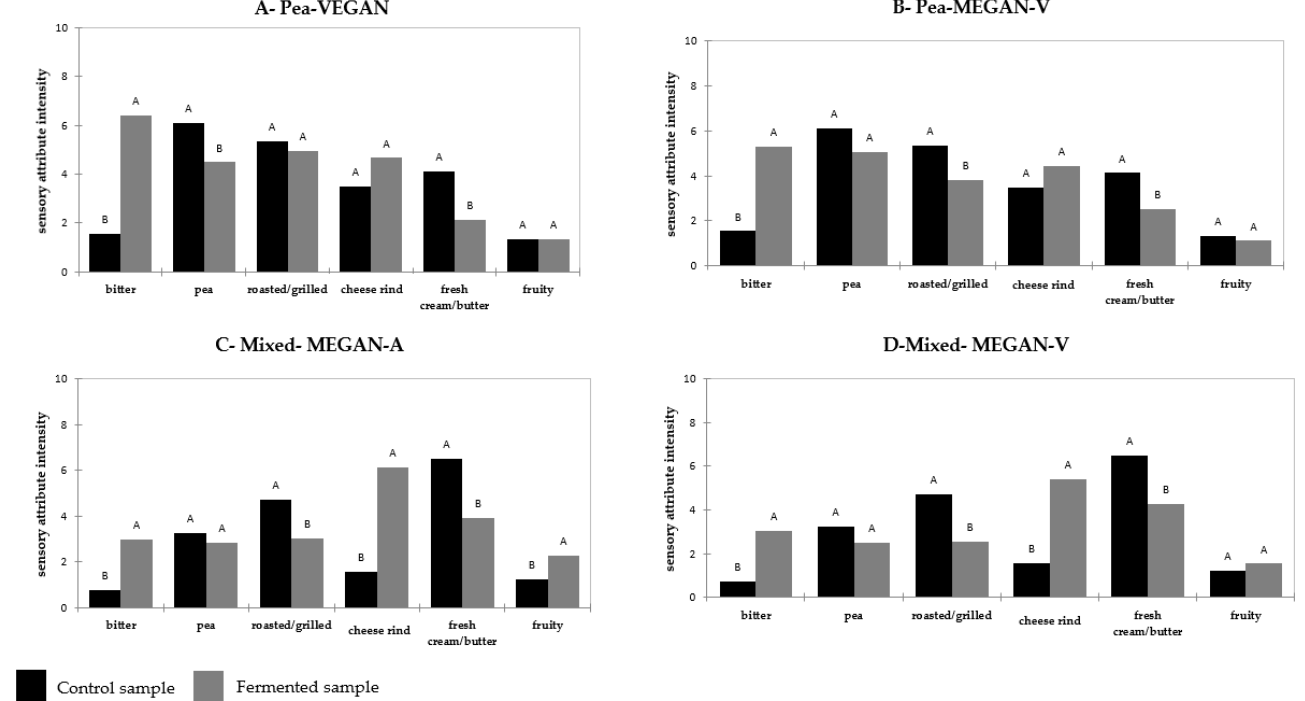
Figure 2. Average intensities of the sensory attributes evaluated during descriptive sensory analysis by panelists for pea and mixed gels. Fermentation effect between control sample (not fermented pea gel) and fermented sample (after three days of fermentation) were determined by ANOVA on each sensory attribute. Letters A and B indicate means that significantly differ between products at p < 0.05 (Newman – Keuls test). ( A ) Pea gels fermented by VEGAN consortium, ( B ) Pea gels fermented by MEGAN-V consortium, ( C ) Mixed gels fermented by MEGAN-A consortium, ( D ) Mixed gels fermented by MEGAN-V consortium.